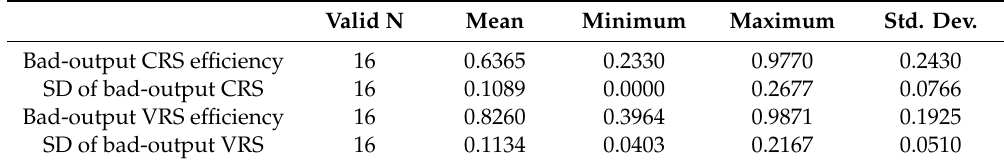
Table 3. Bad-output model (e ffi ciency and standard deviation) with CRS and VRS